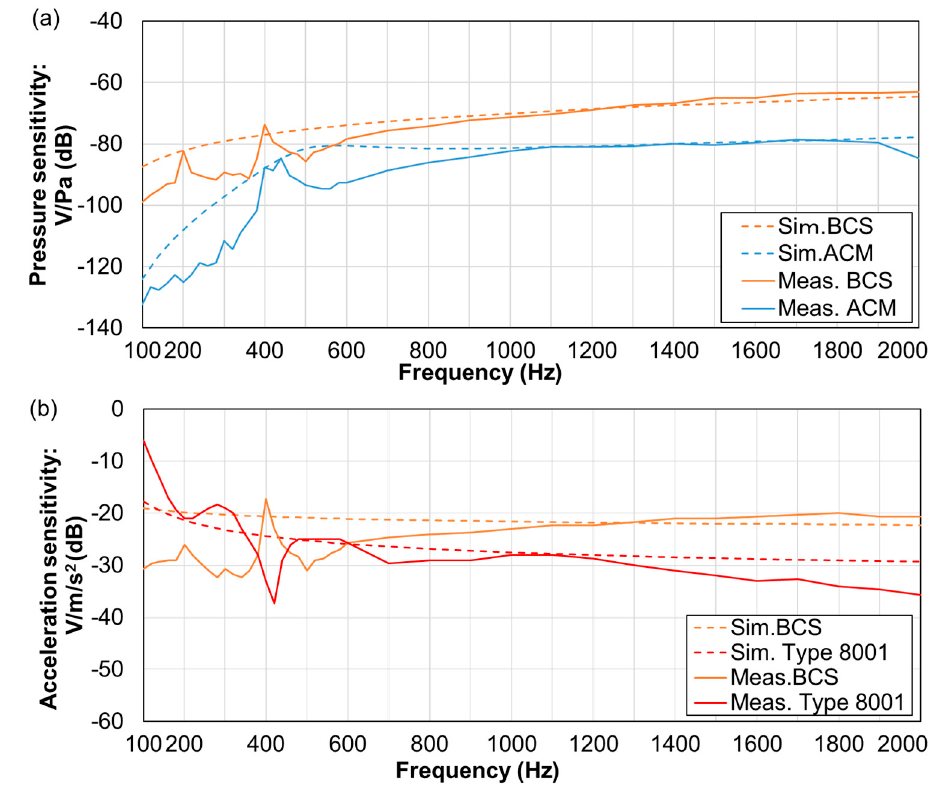
Figure 6. Frequency characteristics of sensors: ( a ) BCS and ACM voltage / pressure sensitivity. ( b ) BCS and type 8001 voltage / acceleration sensitivity.